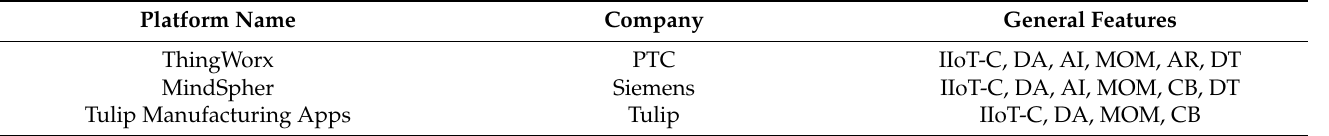
Table A2. List of leading Industry 4.0 ready